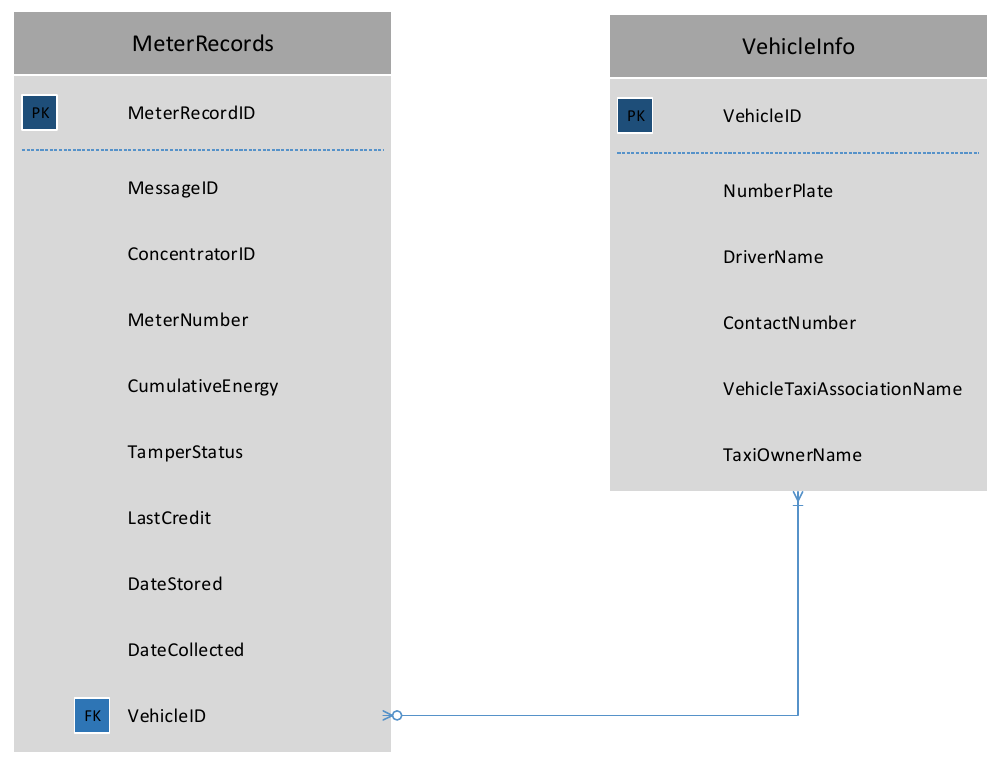
Figure 10. Data mule flow diagram.